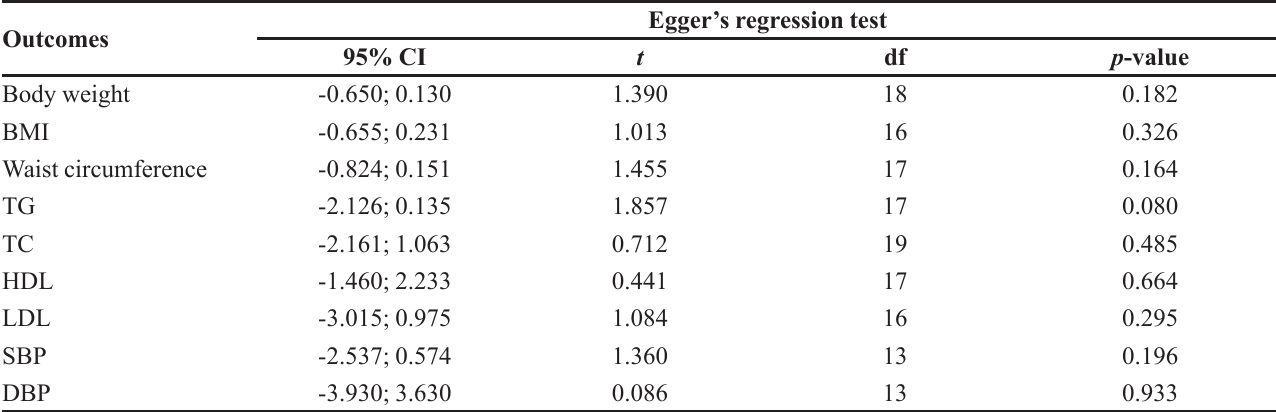
TABLE III - Assessment of publication bias for the impact of I. paraguariensis consumption on the considered outcomes Outcomes